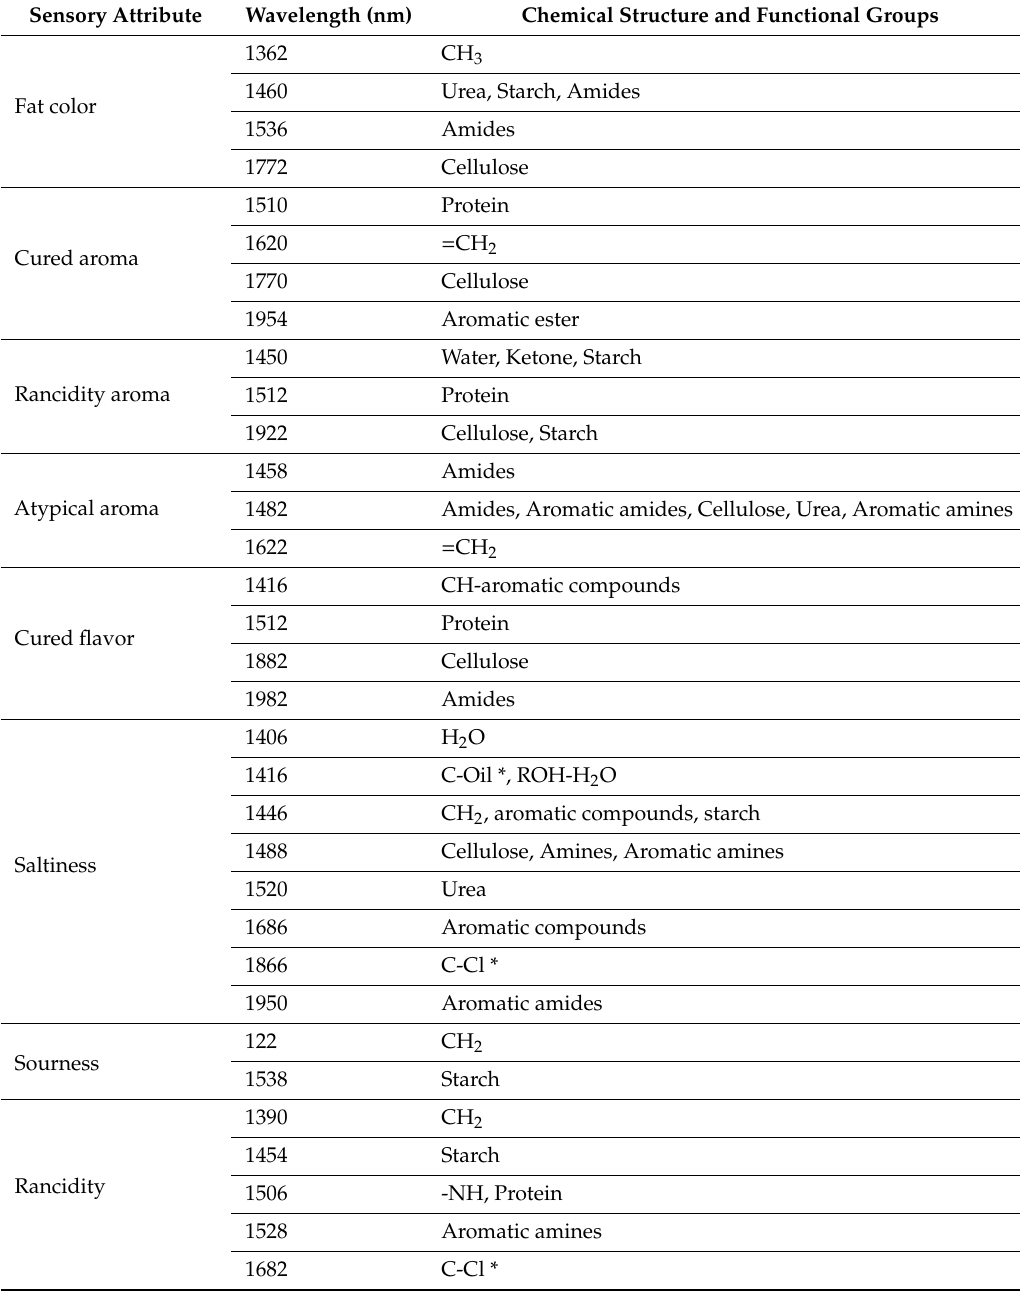
Table 3. Sensory attributes for which it has been possible to establish a relationship with the spectral wavelengths and the chemical groups responsible for the perception of this